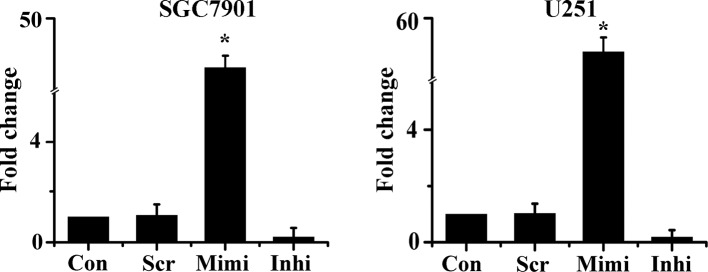
miR-200a expression in SGC7901 and U251 cells. MiR-200a mimic, inhibitor or scrambled control were delivered into SGC7901 and U251 cells. Cells transfected with the miR-200a mimic showed a higher level of miR-200a expression, while cells transfected with miR-200a inhibitor were silenced for miR-200a expression.